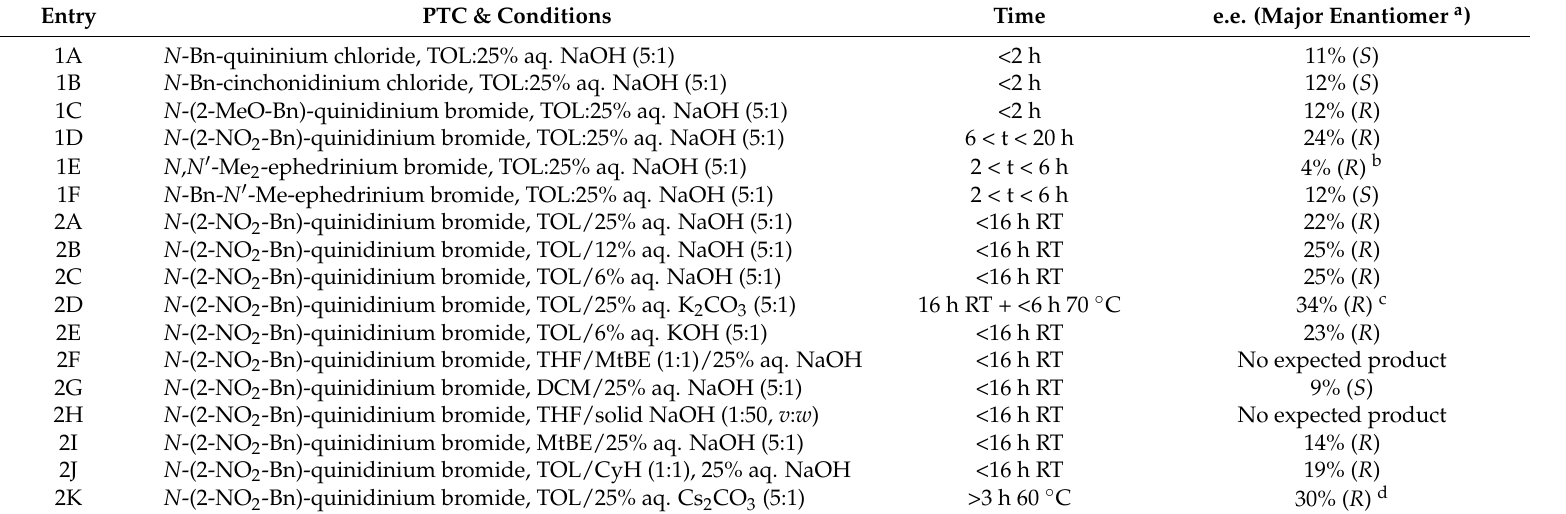
Table 1. Chiral PTC promoted alkylation of ketone 3 and t